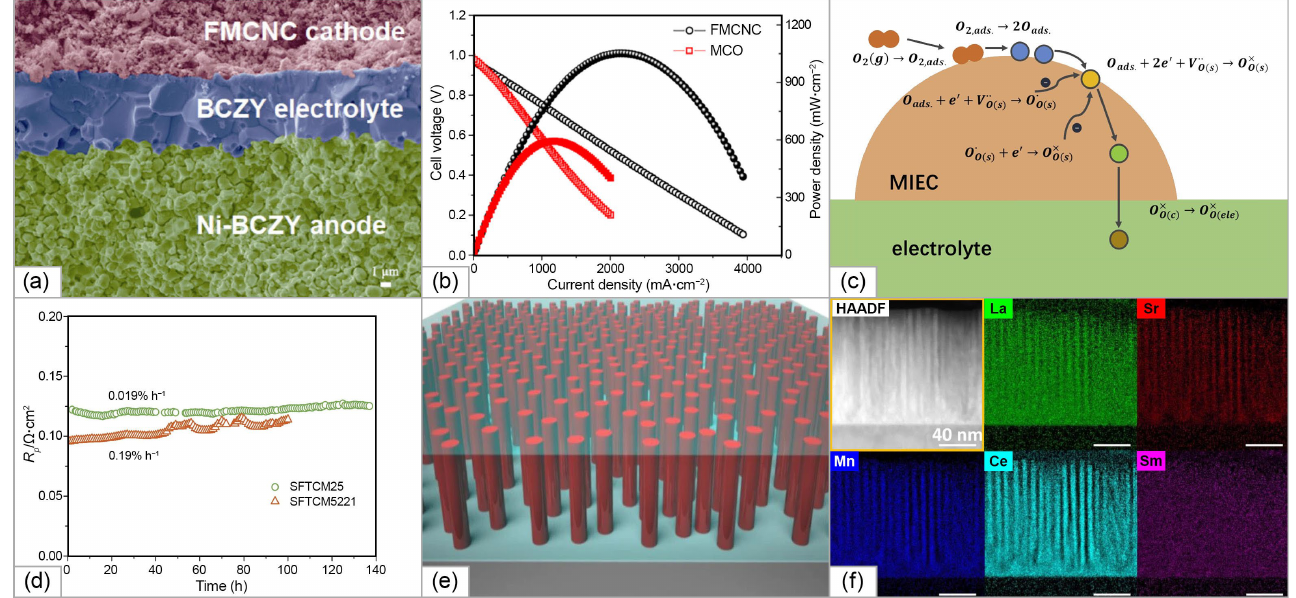
Figure 16. ( a ) Cross-section image of NiO-BCZY|BCZY|GDC|FMCNC single cell; ( b ) fuel cell performances for NiO-BCZY|BCZY|GDC|FMCNC and NiO-BCZY|BCZY|GDC|MCO single cells at 700 °C; ( c ) scheme of oxygen reduction reaction on MIEC cathode; ( d ) polarization resistance of SrFe 0.25 Ti 0.25 Co 0.25 Mn 0.25 O 3- δ (SFTCM25) and SrFe 0.5 Ti 0.2 Co 0.2 Mn 0.1 O 3- δ (SFTCM5221) cathodes on LSGM electrolyte at 700 °C; ( e ) LSM-SDC VAN structure: schematic 3D-image; ( f ) columnar structure of the film (HAADF, image) and EDS maps of elements distribution in the film (( a , b ) are reproduced from [187]; ( c , d ) are reproduced from [188] with permission of Elsevier; ( e , f ) are reproduced from [227]).